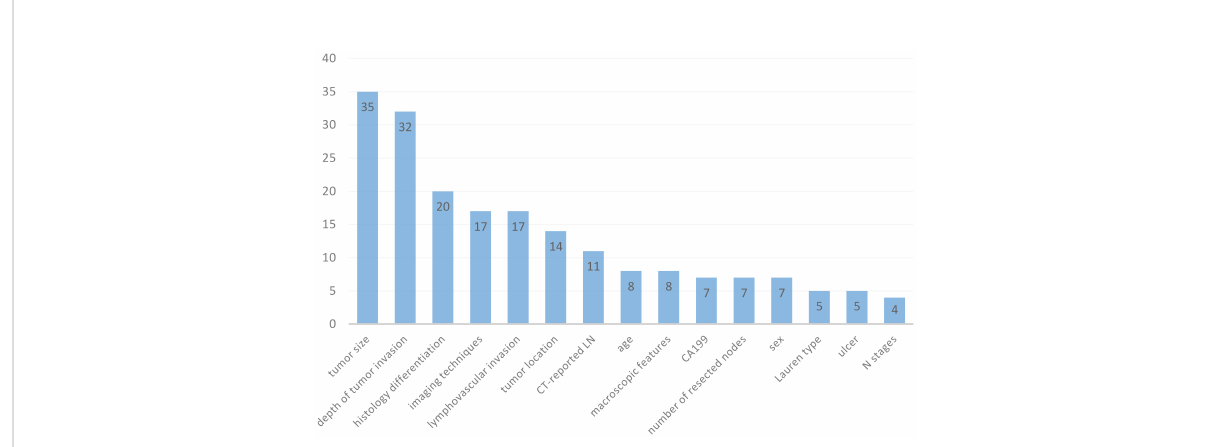
FIGURE 3 15 most frequently used predictors in 61 prediction models for gastric cancer